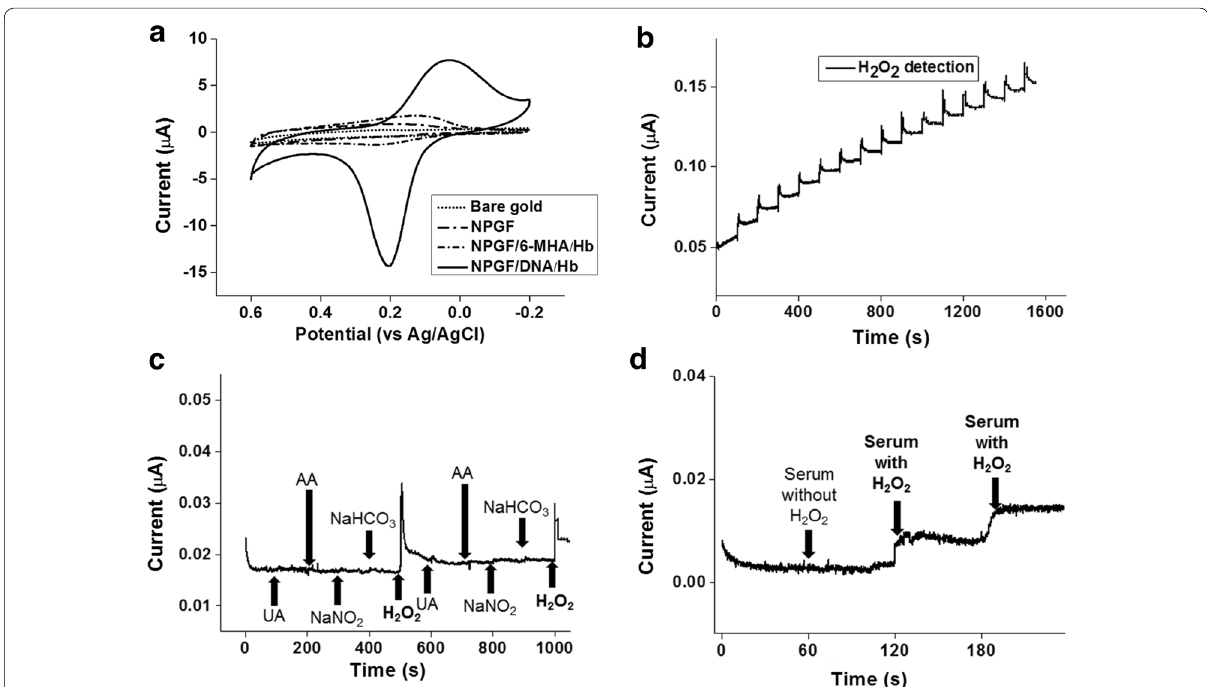
Fig. 4 a Cyclic voltammograms of Bare gold, NPGF electrode, NPGF/6‑MHA/Hb, NPGF/DNA/Hb in PBS; amperometric i‑t curves of b addition of 10 μL of 100 μM H 2 O 2 solution; c Successive addition of 1 µM UA, AA, NaNO 2 , NaHCO 3 , and 1 µM H 2 O 2 solution; d successive addition of serum without H 2 O 2 once and serum with 1 µM of H 2 O 2